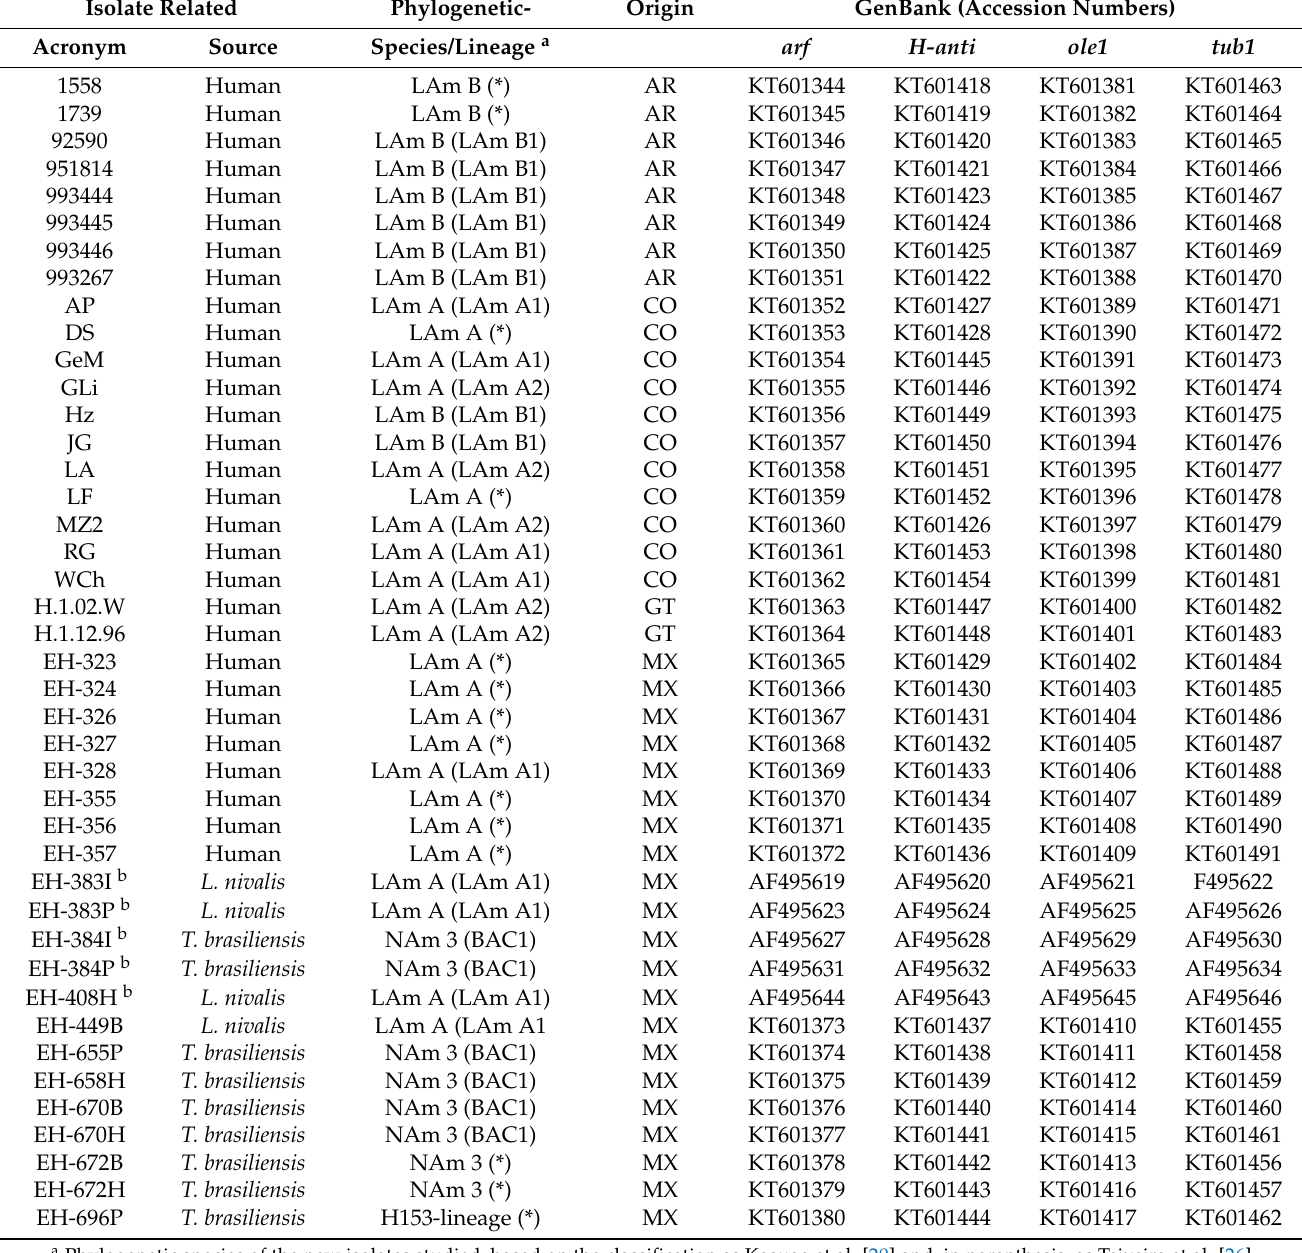
Table 1. Data about the new H. capsulatum isolates reported in the present